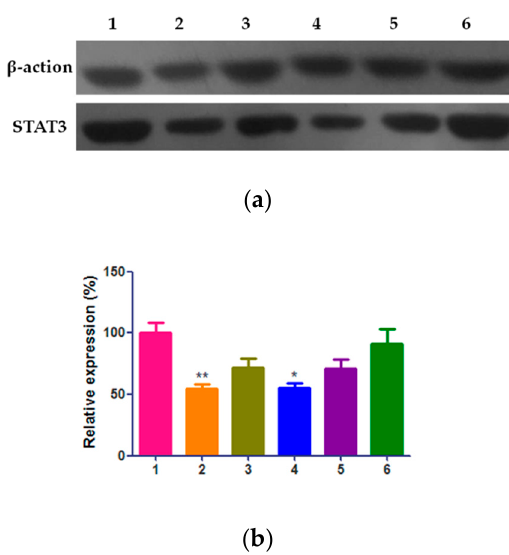
Figure 6. Effect of QE-NCs with different sizes on the protein level of STAT3 in A549 cells ( n = 3). ( a ) Western blot results. ( b ) The results of statistical analysis. 1. Blank control group; 2. Cisplatin 3 μ g/mL group; 3. QE-NCs (200 nm, 15 μ mol/L) group; 4. QE-NCs (200 nm, 30 μ mol/L) group; 5. QE-NCs (500 nm, 30 μ mol/L) group; 6. QE-NCs (3 μ m, 30 μ mol/L) group. * p < 0.05, ** p < 0.01, compared with the blank control group.